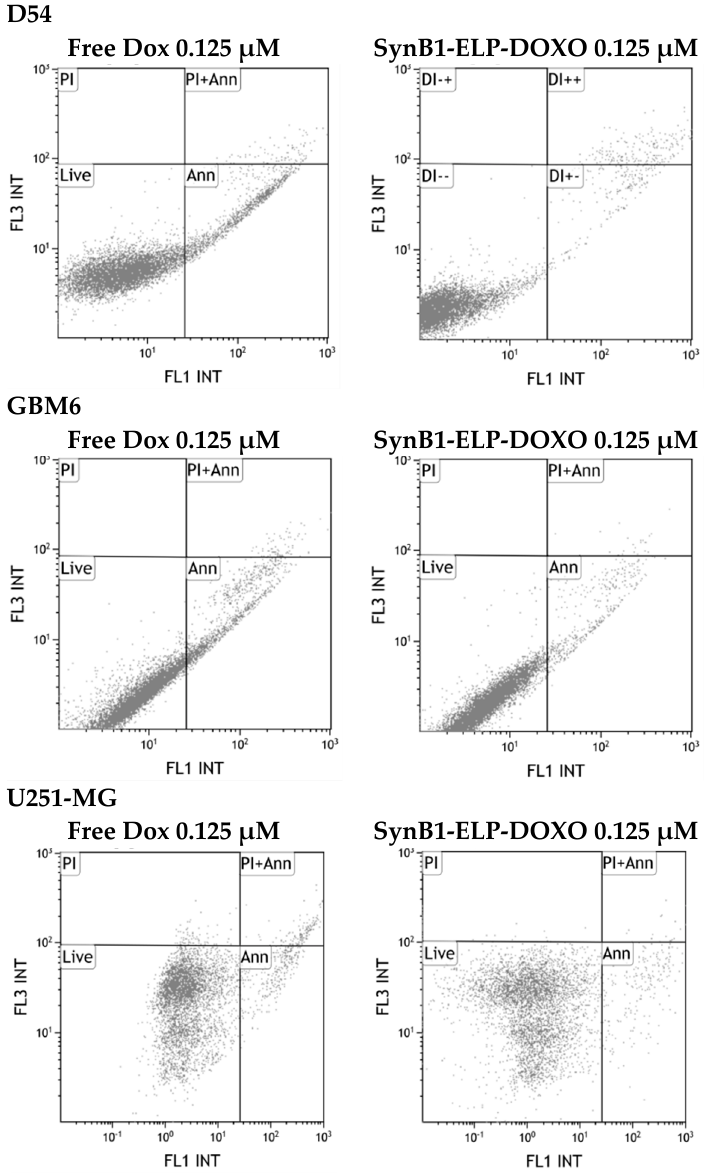
Figure 5. Induction of apoptosis by SynB1-ELP-DOXO in GBM cell lines. Cells were treated with 125 nM SynB1-ELP-DOXO or free Dox and analyzed 24 h after the treatment. Raw data for a representative experiment is shown.